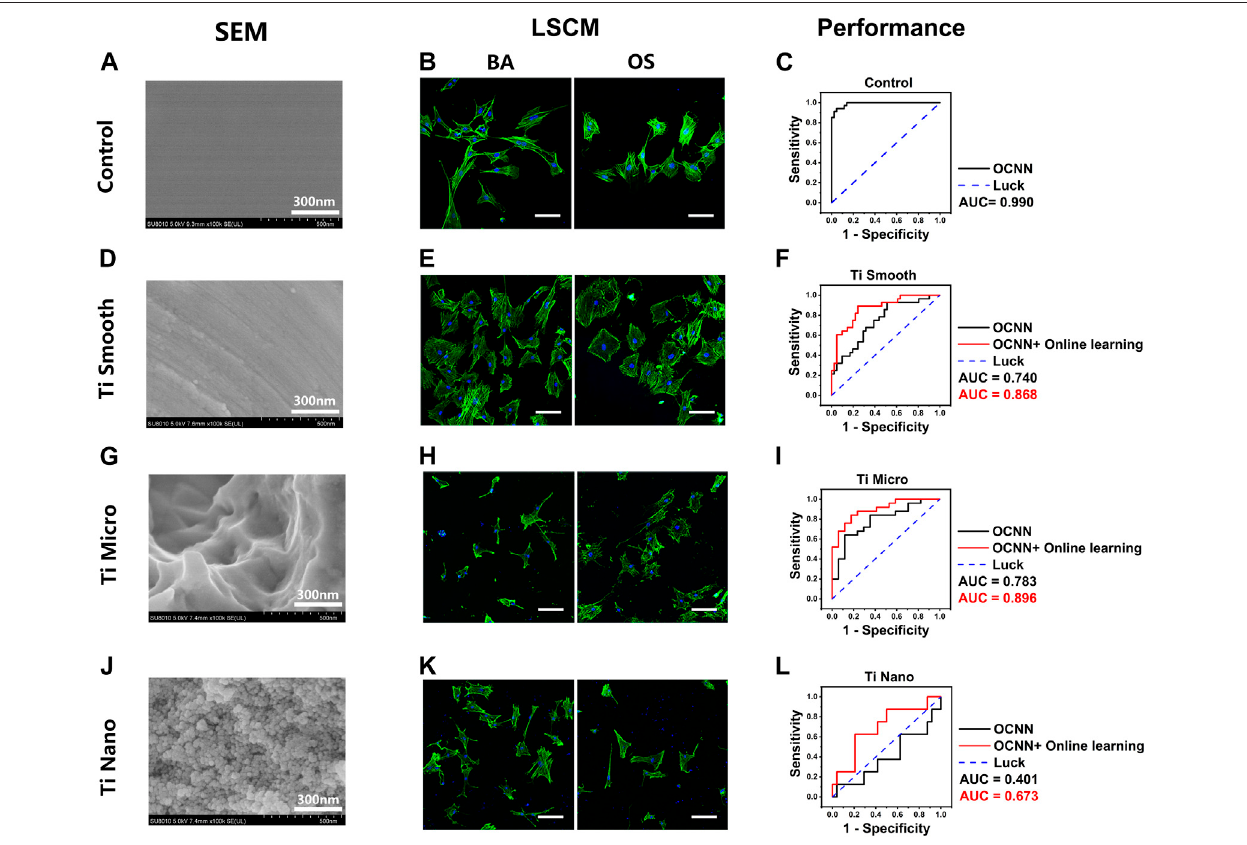
FIGURE5| OCNN prediction andOCNN-basedonlinelearningforrBMSCs ontitaniumsurfaces. (A)(D) (G)(J) SEM imagesofcontrol andthree differenttitanium surfaces:smooth,micro,andnano,scalebar (cid:1) 300 nm. (B)(E)(H)(K) LSCMimagesoftherBMSCsoncontrolandthreedifferenttitaniumsurfaces:smooth,micro,and nano.Basalmedium(BA),osteogenicsupplementmedium(OS).Inductiontime:24 h;green:F-actin;blue:nuclei.Scalebar,100 µm. (C)(F)(I)(L) ComparisonofOCNN prediction and OCNN-based online learning results using ROC curves. Black line: OCNN prediction; red line: OCNN accompanied with online